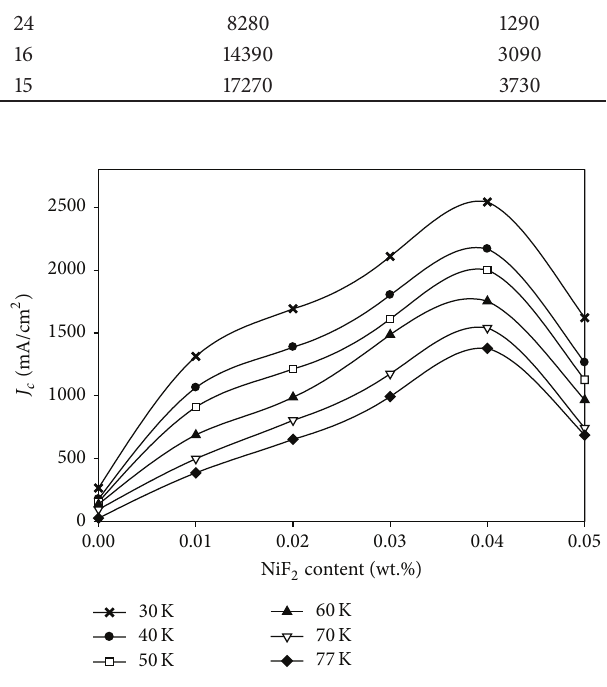
Figure 1: Critical current density, 𝐽 𝑐 , of Bi-2223 pellets as function of wt.% NiF 2 content between 30 K and 77 K.